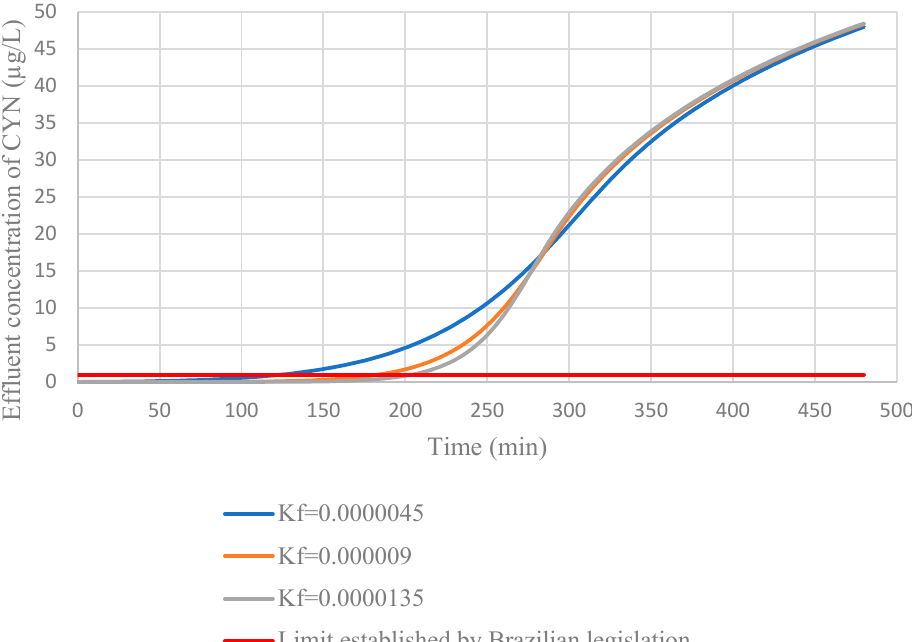
Figure 11. Sensitivity analysis of the model from changes in the value of the mass transfer coefficient, Kf. Input values used in the model: EBCT = 10 min; Apparent bed density = 0.476 g/cm 3 ; Grain density = 0.850 g/cm 3 ; Average grain diameter = 0.855 mm; Initial CYN concentration = 100 µ g/L; Flow = 700 L/s; Equilibrium coefficients (Langmuir isotherm) q max = 3670 µ g/g, KL = 0.2791 L/ µ g; Surface diffusion coefficient, D s = 3 × 10 − 16 m 2 /s.